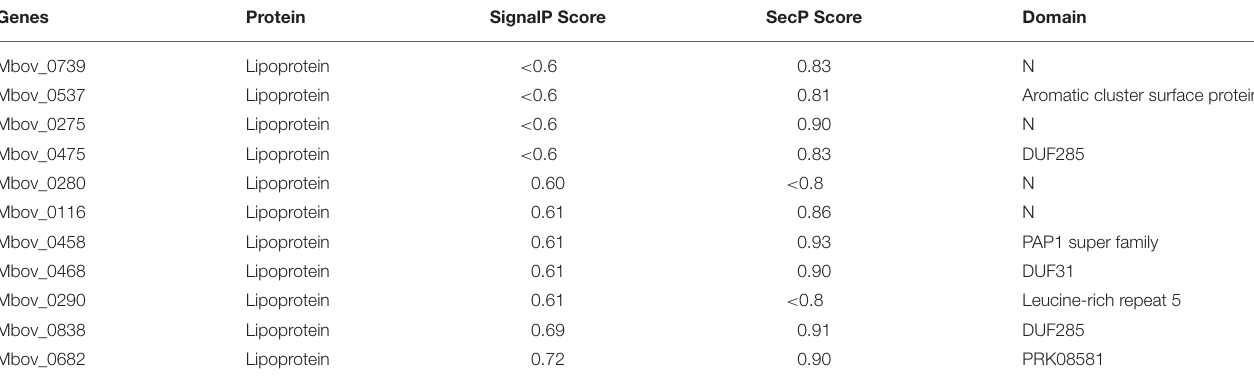
TABLE 2 | Information on 11 predicted secreted proteins. Genes Protein SignalP